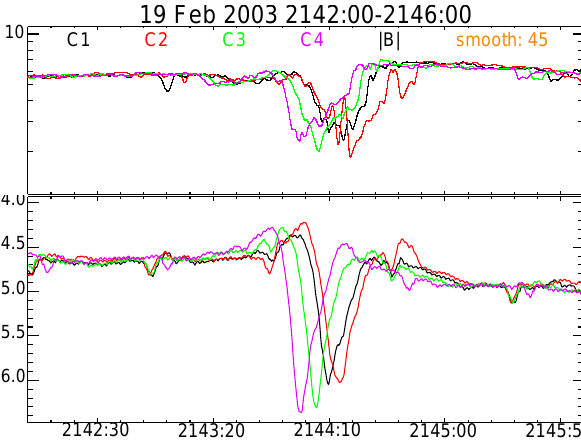
Fig.9. Fig. 9. 19 February 2003 21:42–21:46UT, magnetic field intensity and φ SC .